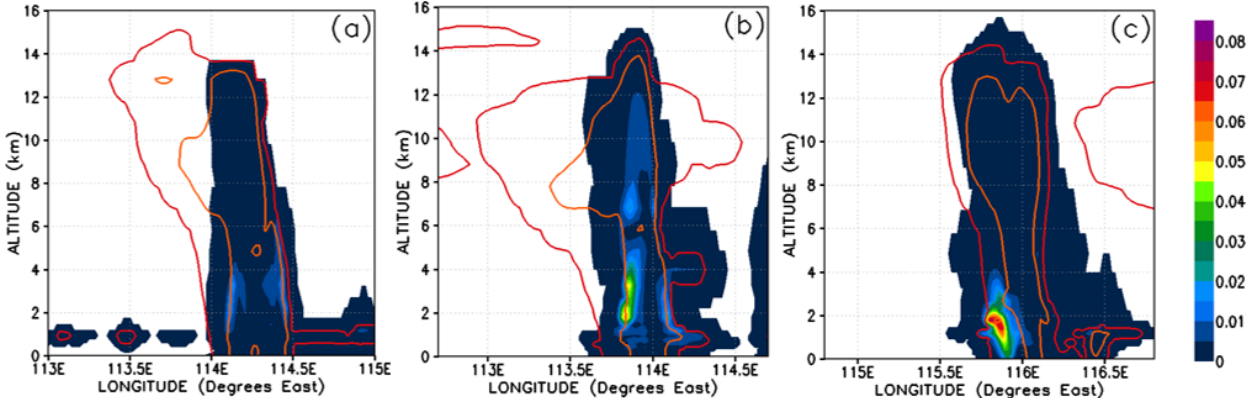
Figure 15. Vertical cross sections of mixing ratios (expressed in Br pptv) of Br 2 . The left, middle, and right columns correspond to cross sections of Mod_Conv_4.35N at 4.35 ◦ N at 06:00UTC, Mod_Conv_3.75N at 3.75 ◦ N at 09:00UTC, and Mod_Conv_5.4N at 5.4 ◦ N at 09:00UTC. Note that the lines representing the 0.01 and 0.5gkg − 1 contours of the simulated condensed water are plotted in this figure as red and orange,